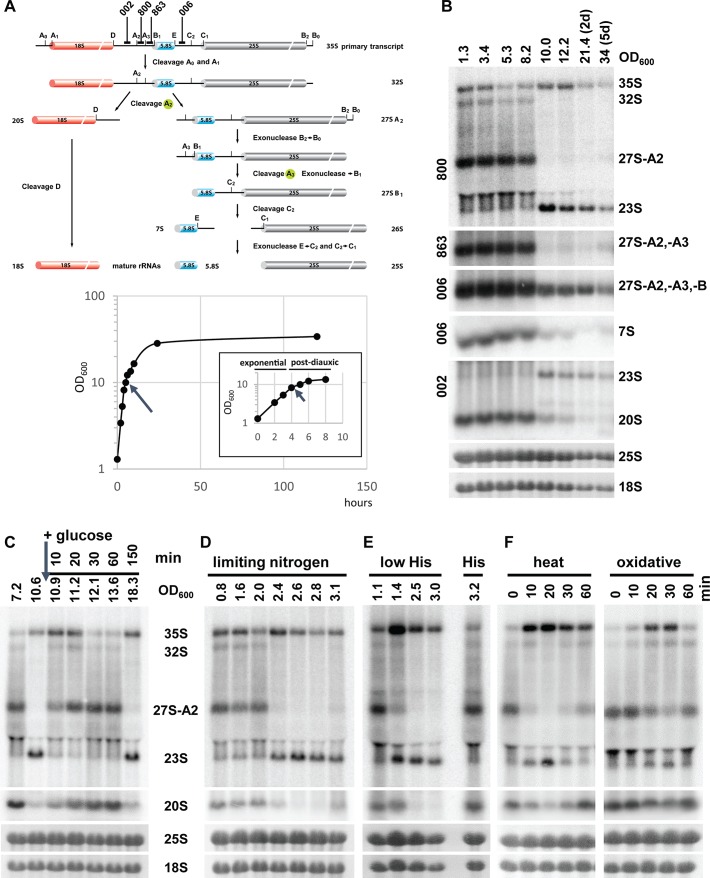
Pre-rRNA processing switches between the A2 and A3 pathways.(A) A scheme of pre-rRNA processing in yeast, simplified from [22]. Positions of oligonucleotides used as hybridization probes are indicated above. (B) Northern blot analysis of the pre-rRNA processing during different stages of growth. Wild-type yeast YMK118 was grown in YPD for up to 5 d. A growth curve with OD600 values plotted against time is shown. An evaporation of culture media during extended cultivations likely affected the OD600 reading. From our measurement, the error was <20% on day 5. The arrows indicate the time of the switch in pre-rRNA processing. Total RNA was isolated from the same number of cells and analyzed by northern blotting. The probes used for hybridization are indicated left of the gels. The mature 25S and 18S rRNAs were stained with Methylene blue after blotting to a nylon membrane. (C) YMK118 was grown in YPD (2% glucose). After yeast entered the postdiauxic phase, 1% glucose was added (arrow). Samples were harvested at indicated times. Total RNA was analyzed by northern blotting, using the A2–A3 probe. (D) Nitrogen limitation: YMK118 was grown in synthetic dextrose complete (SDC) media with limiting amounts of ammonium sulphate (625 mg/L, i.e., 8-fold less than in standard SDC media). Total RNA was analyzed as in (C). (E) Amino acid starvation; wild-type strain YMK118 was grown in SDC with limiting amounts of histidine (“low His”) (2 mg/L, i.e., 10-fold less than standard SD media). (F) Environmental stress: exponentially growing YMK118 was shifted from 25°C to 37°C or exposed to 0.2 mM Diamide. Total RNA was harvested at indicated times and analyzed as in (C).